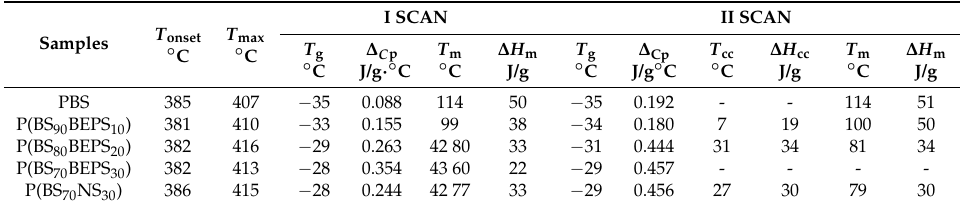
Table 2. Thermal characterization data of PBS and P(BS m BEPS n ) and P(BS 70 NS 30 ) random copolymers.